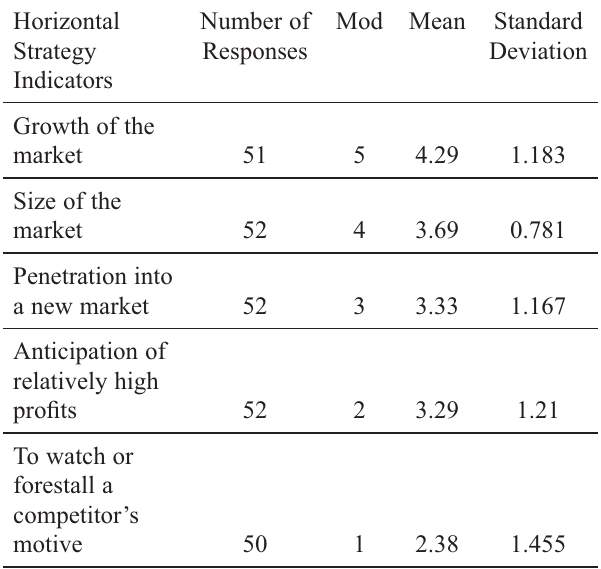
Table 3 . Motives for Foreign Direct Investment in Turkey Horizontal